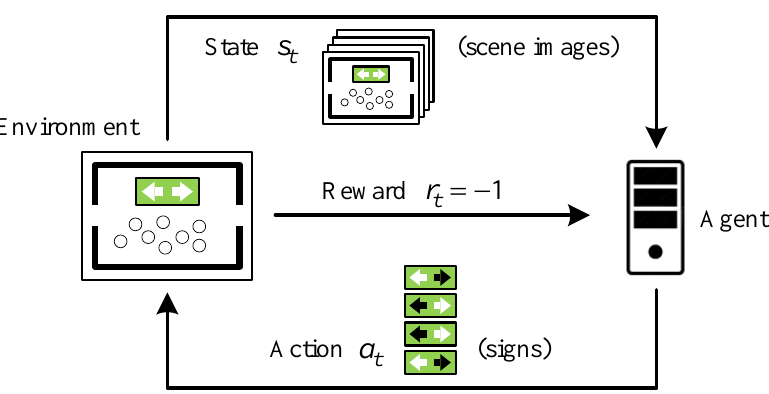
Figure 2. Reinforcement learning model for evacuation